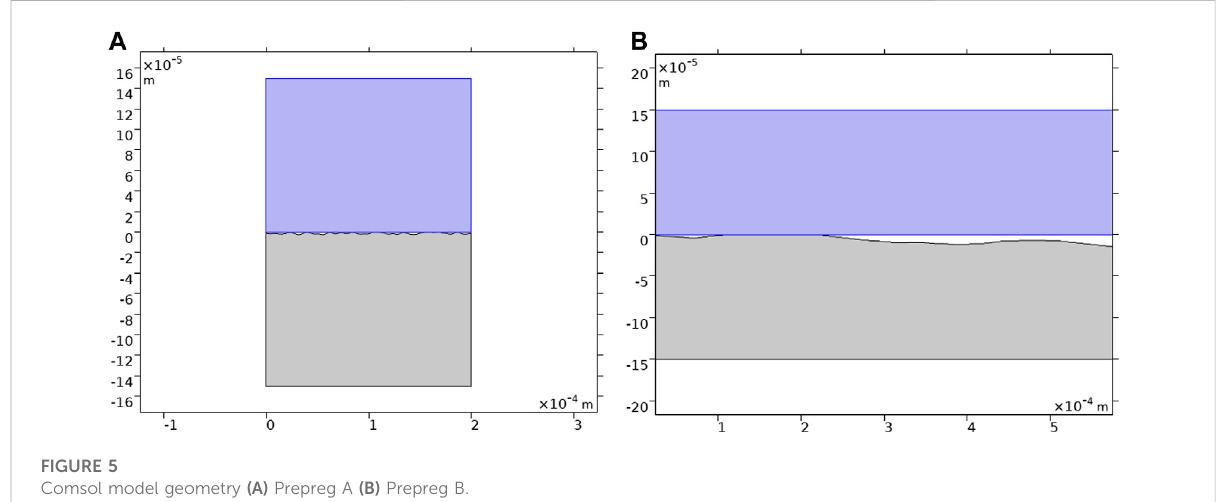
FIGURE 5 Comsol model geometry (A) Prepreg A (B) Prepreg B.